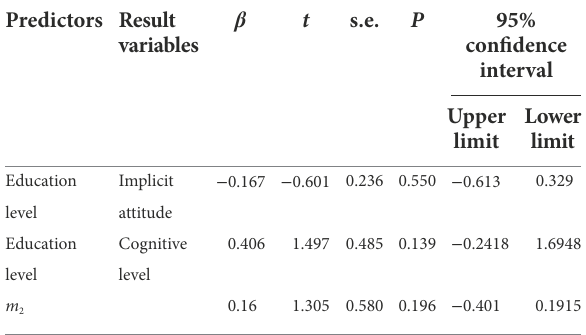
TABLE 4 Mediating effect analysis (SC-IAT).